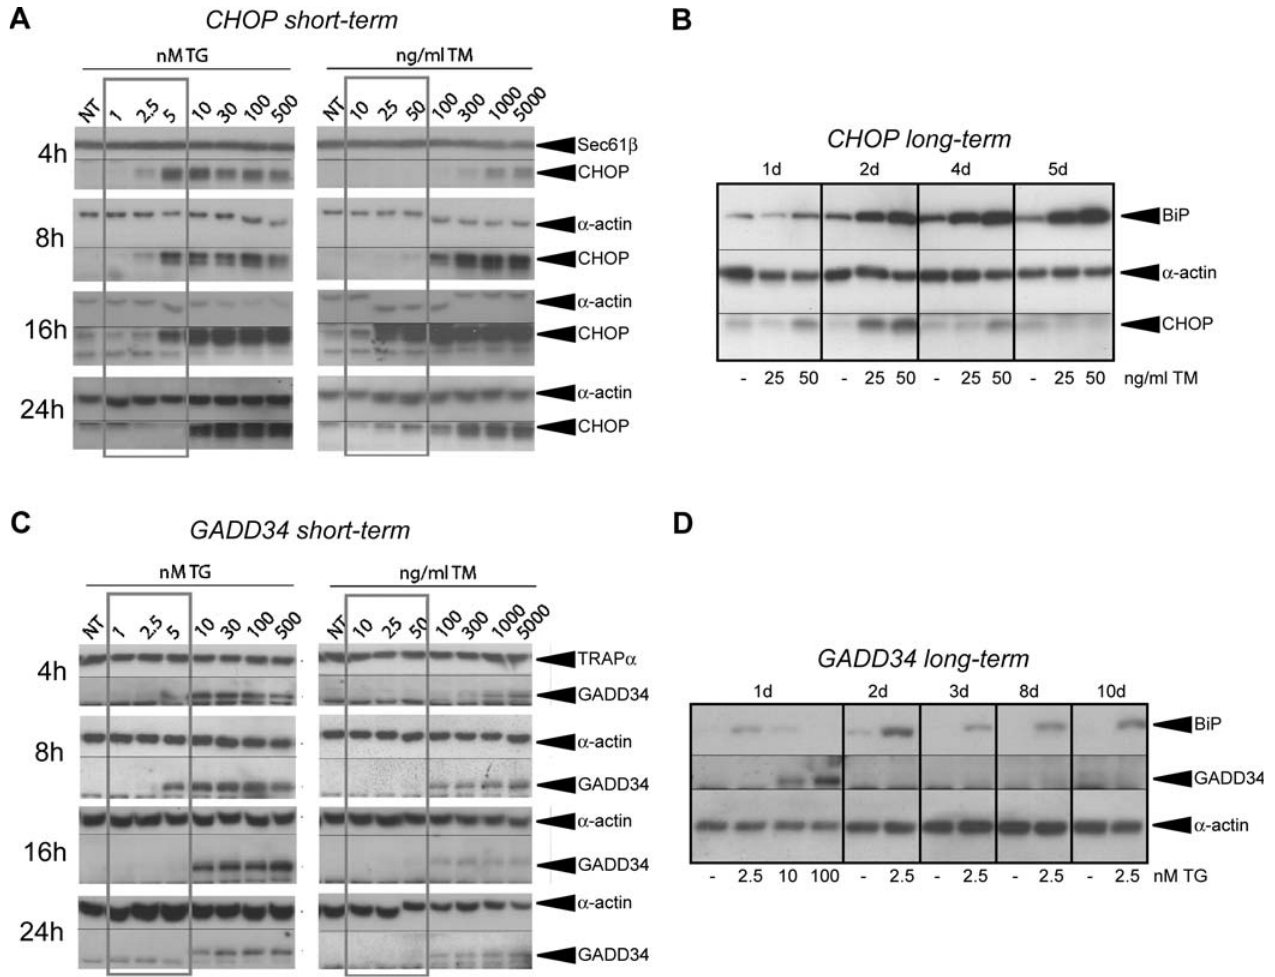
Figure 3. Expression of CHOP and GADD34 Correlates with Cell Fate (A) MEFs were treated with increasing concentrations of TG or TM for the indicated times, followed by cell lysis and immunoblot for CHOP, or a -actin or Sec61 b to judge loading. The concentrations outlined by the gray box are those that allow for survival. For every time-point, the TM and TG panels were taken from the same blot, and the same exposure time. (B) MEFs were treated for up to 5 d in the continuous presence of 25- or 50-ng/ml TM, with the media and stressor refreshed each day; and expression of CHOP, BiP, and a -actin was probed by immunoblot. (C) Same as in (A), probing instead for GADD34, or a -actin or TRAP a as loading controls. (D) Cells treated continuously in TG at the indicated concentrations were probed for expression of BiP, GADD34, and a -actin by immunoblot. DOI: 10.1371/journal.pbio.0040374.g003